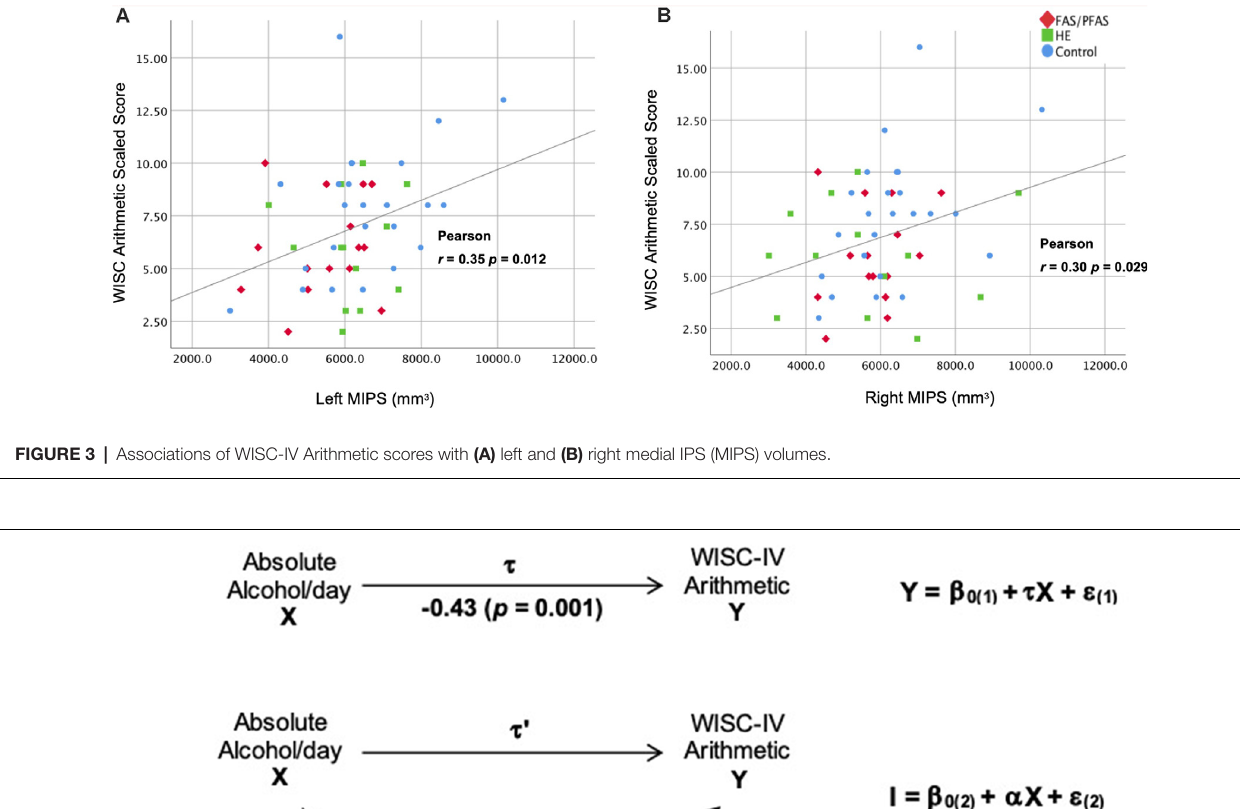
MIPS in the current study. The posterior SPL is activated during certain arithmetic calculations, such as counting (Piazza et al., 2003) and number comparison (Pinel et al., 2001). Since the posterior SPL and anterior portion of the IPS comprise most of our MIPS volumes, it is not surprising that children with larger MIPS volumes performed better on the WISC arithmetic